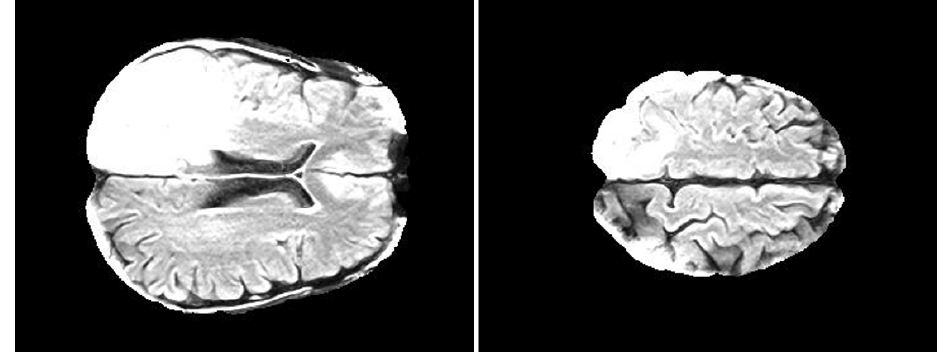
Figure 1. Example of slices contained in the